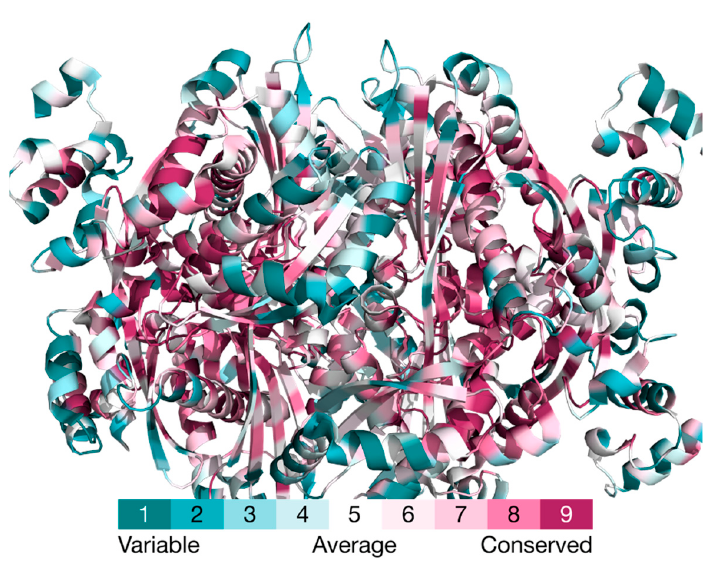
Figure 9. Representation of the conservation score obtained for the catalytic portion of human HMG-CoAR (PDB code 1DQA), using the software ConSurf-DB [55]. It is possible to observe in magenta highly conserved residues, typically with some structural and / or functional importance; the residues with low conservation are in cyan.